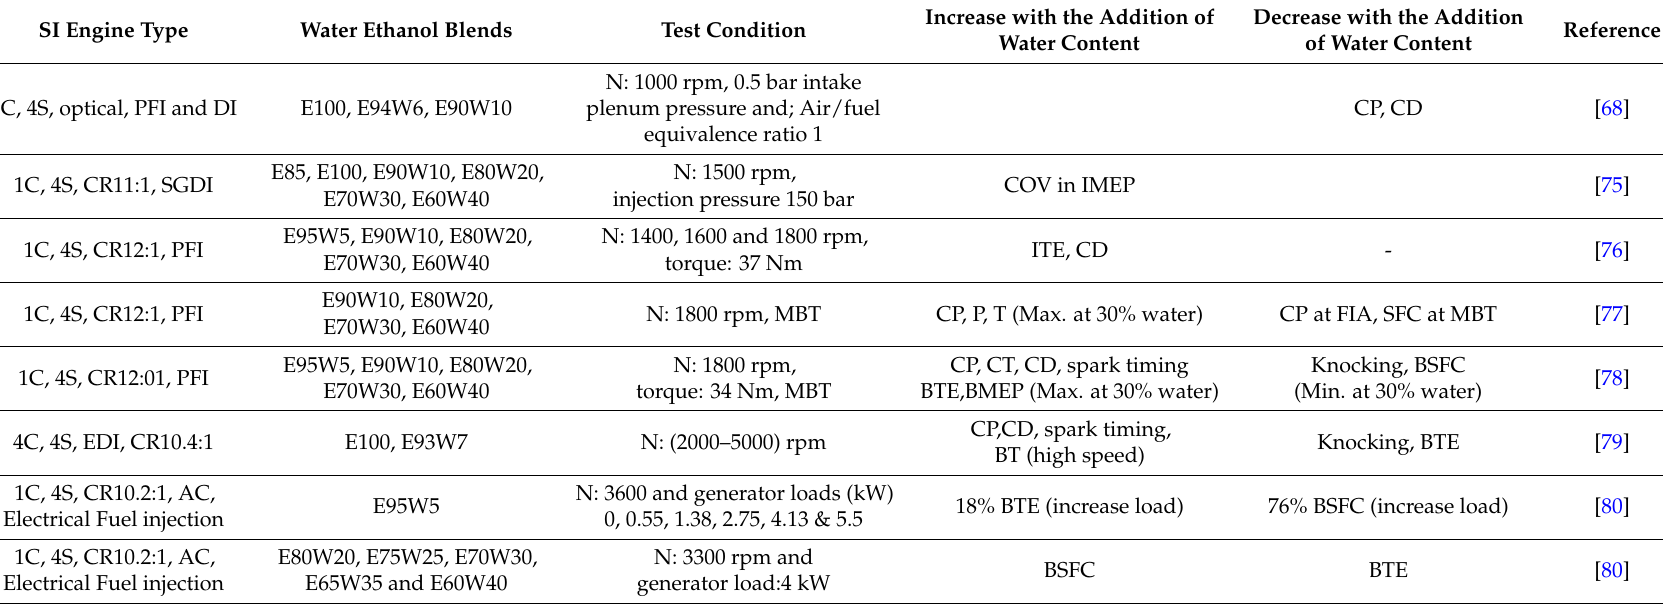
Table 4. Combustion and performance of ethanol fuel with diffrent water content in SI